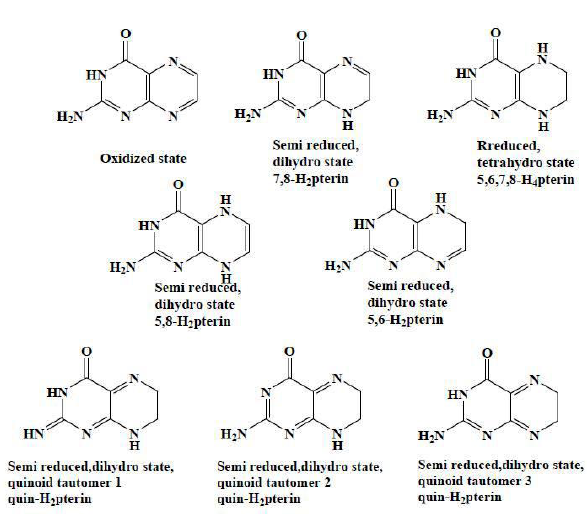
Figure 3: Oxidized and reduced forms of